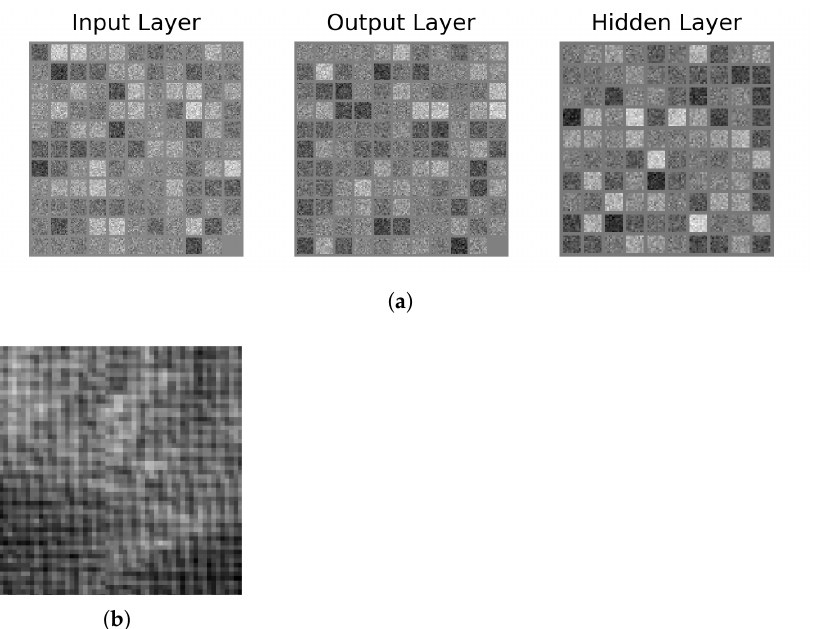
Figure 13. ( a ): Filters learned in by the input, output and hidden layers. ( b ): Filters applied from Memisevic and Hinton [10]. Reproduced with permission from R. Memisevic and G. Hinton, Unsupervised Learning of Image Transformations; published by IEEE, 2007.